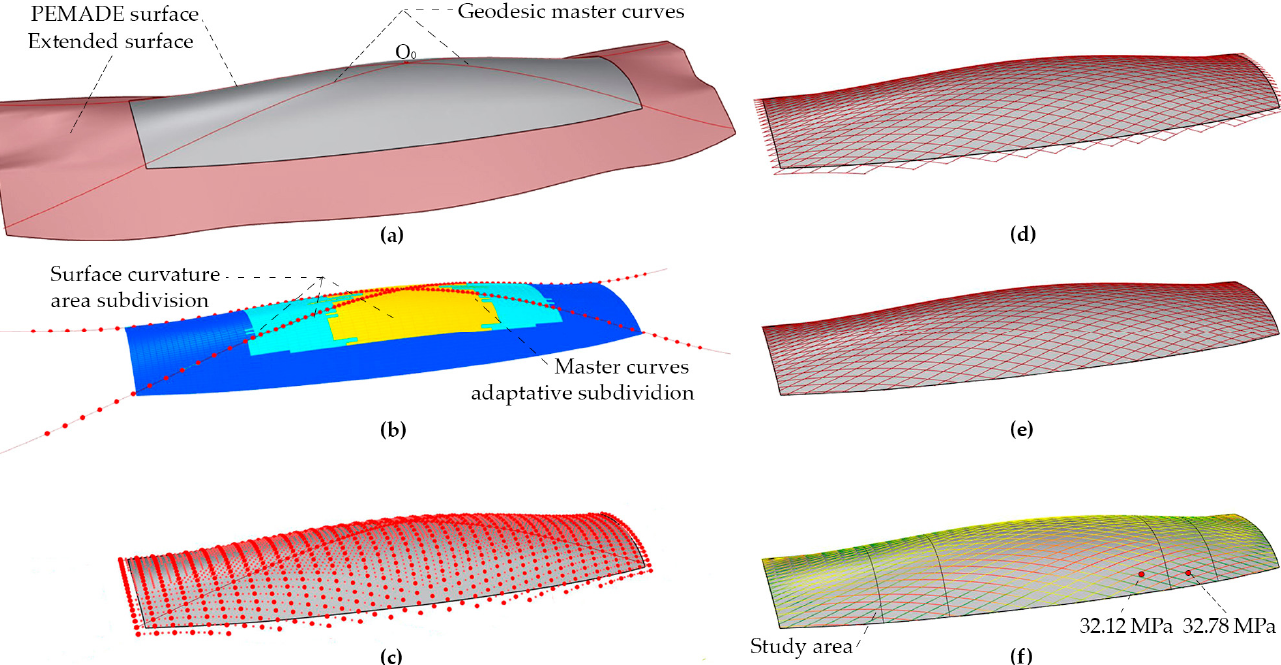
Figure 18. Parametric model and simulation applied on the PEMADE surface: ( a ) Extended surface and geodesic master curves; ( b ) Surface subdivision based on curvature and adaptative subdivision of geodesic curves; ( c ) Grid points by Adaptative Compass Method; ( d ) Untrimmed mesh; ( e ) Trimmed mesh; ( f ) Initial stresses.